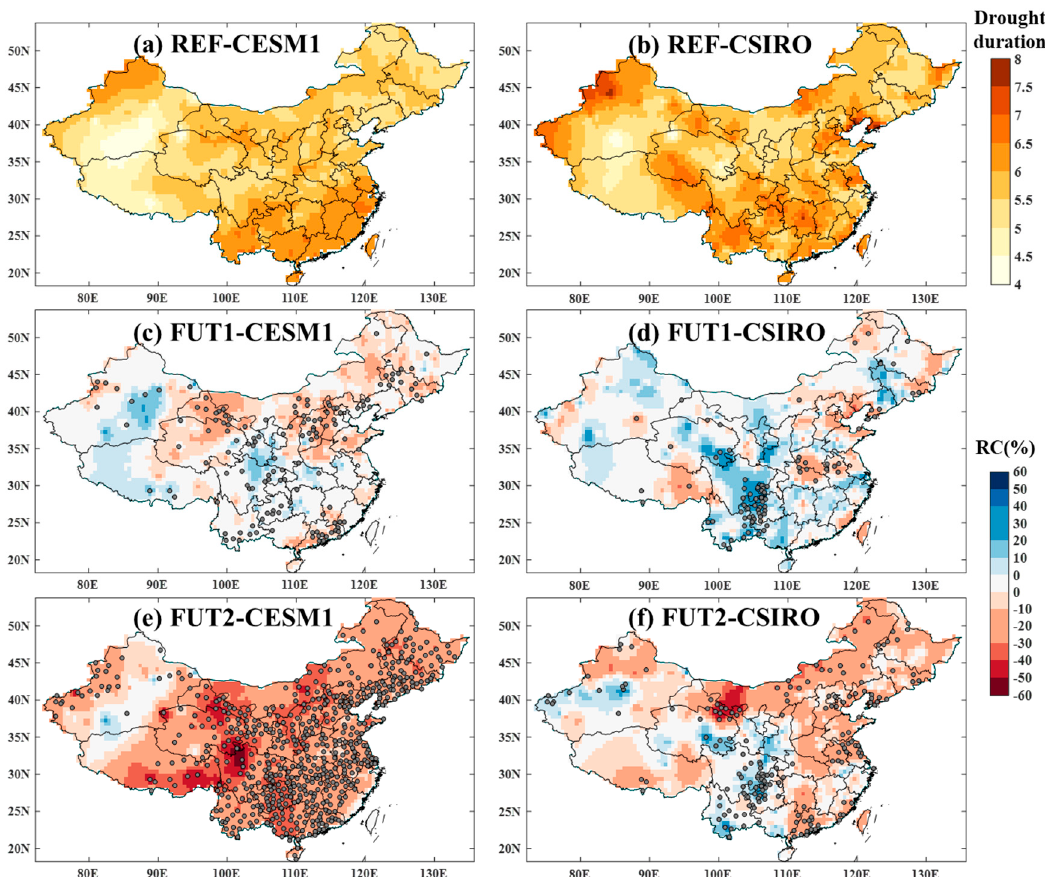
Figure 9. Spatial patterns of drought duration with a 50-year return period in the reference period (REF) and the relative changes (RC) in future periods (FUT1, FUT2) for two climate model ensembles. Stations that present statistically significant changes are marked with filled dots. ( a )The 50-year return period of drought duration in REF for CESM1; ( b ) The 50-year return period of drought duration in REF for CSIRO; ( c ) The RC of the 50-year return period of drought duration in FUT1 for CESM1; ( d ) The RC of the 50-year return period of drought duration in FUT1 for CSIRO; ( e ) The RC of the 50-year return period of drought duration in FUT2 for CESM1; ( f ) The RC of the 50-year return period of drought duration in FUT2 for CSIRO.